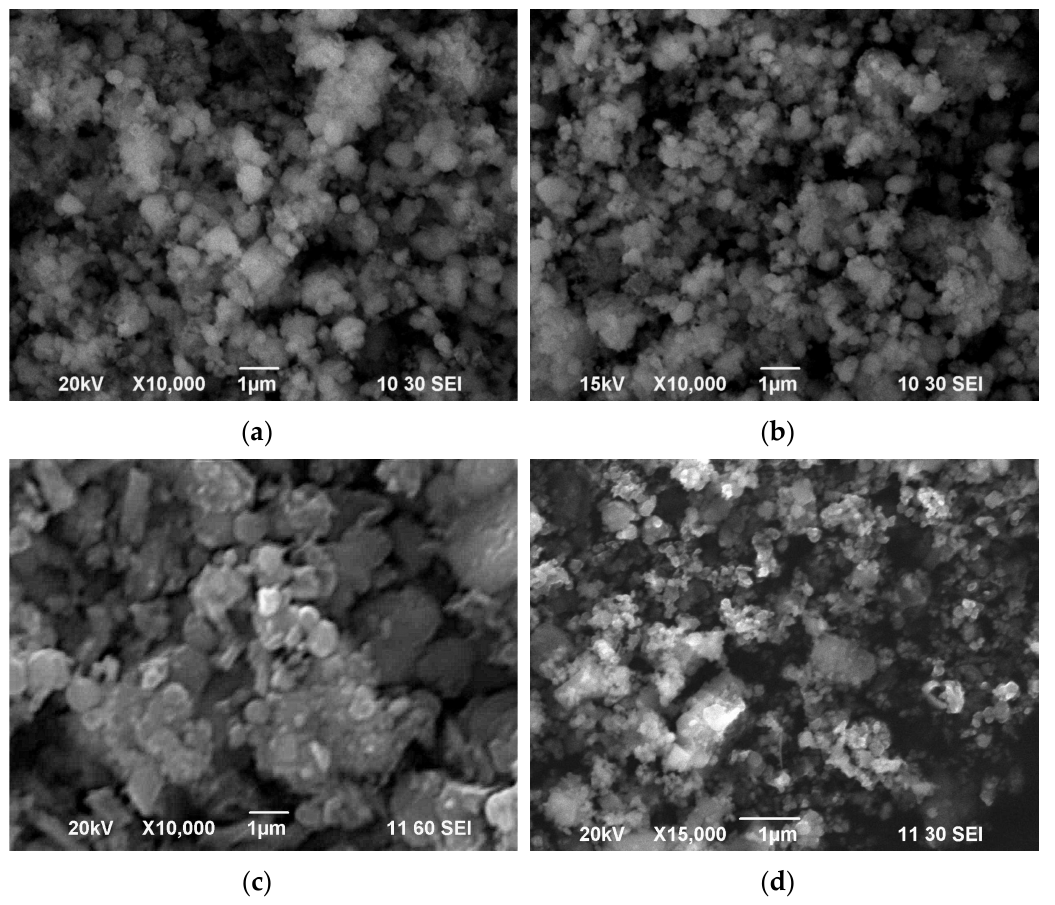
Figure 5. Microphotographs of red muds: ( a ) red mud obtained by alkali fusion at 300 °C; ( b ) red mud obtained by alkali fusion at 500 °C; ( c ) red mud obtained by alkali fusion at 500 °C; ( d ) industrial Bayer red mud.